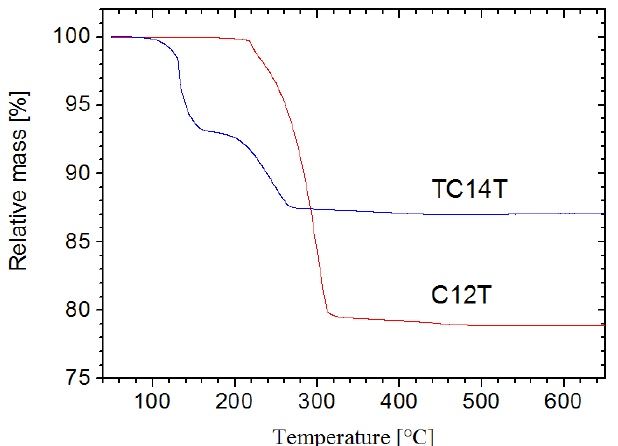
Figure 5. Thermogravimetric analysis of gold particles coated with 1-dodecanethiol (C12T) or tert -tetradecanethiol